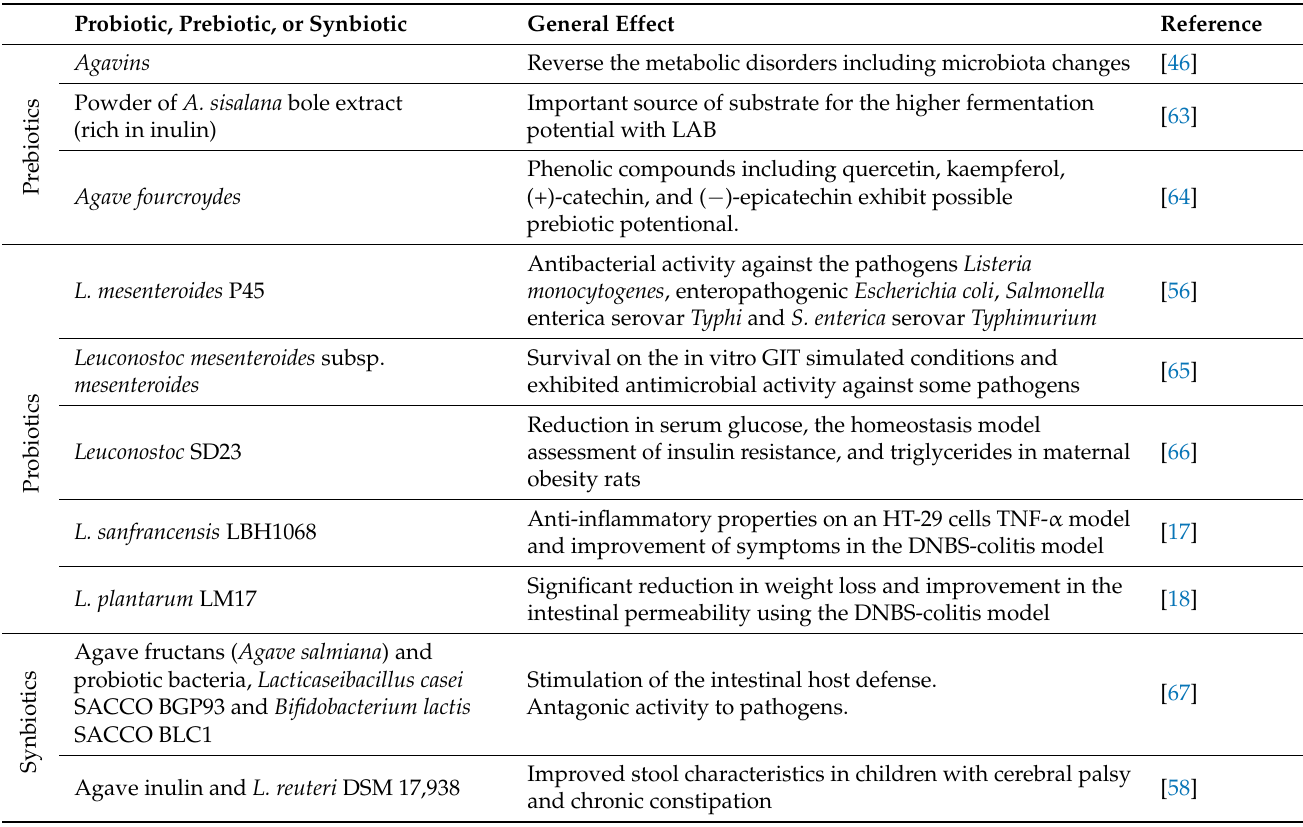
Table 2. Prebiotics, probiotics, and synbiotics in Agave